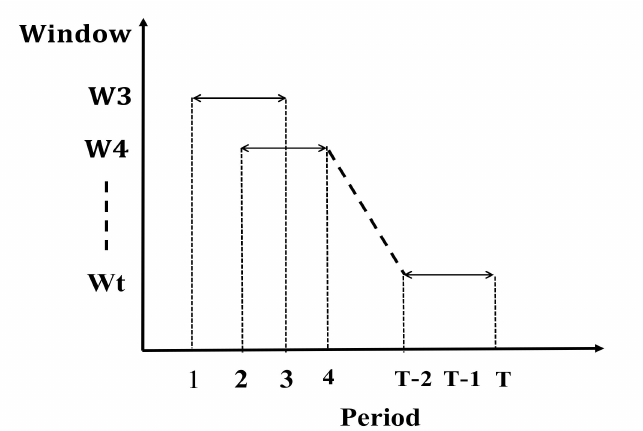
Figure 2. Structure of Window Analysis (with Three Periods). Note: The first window (W3) uses decision-making units (DMUs) under the three periods (1, 2, and 3) for measurement. The window analysis measures the performance of the k th DMU in the third period as the starting point. The window shifts the length by one period. The index measurement starts DMUs in the fourth period. The window consists of the three periods (1, 2, and 3), and measures the DMU performance in the fourth